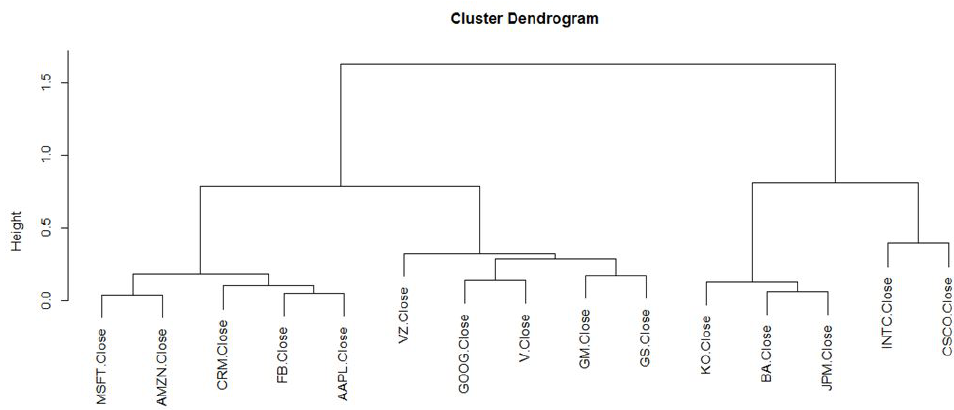
Figure 1. Clusters obtained in the first